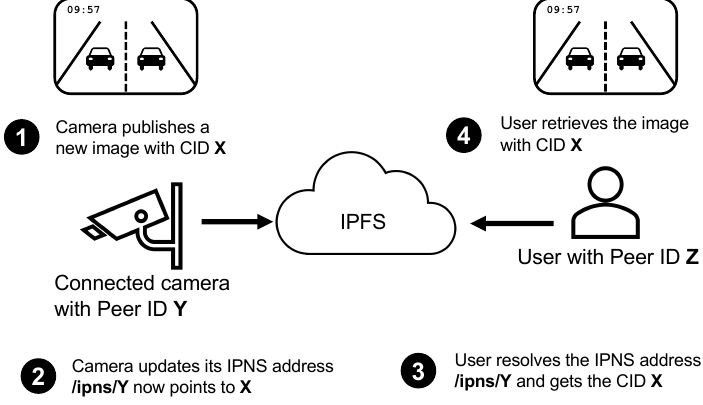
Figure 5. A camera publishes a new image using its peer ID and the user resolves the camera Inter-Planetary Name System (IPNS) address to fetch the latest published